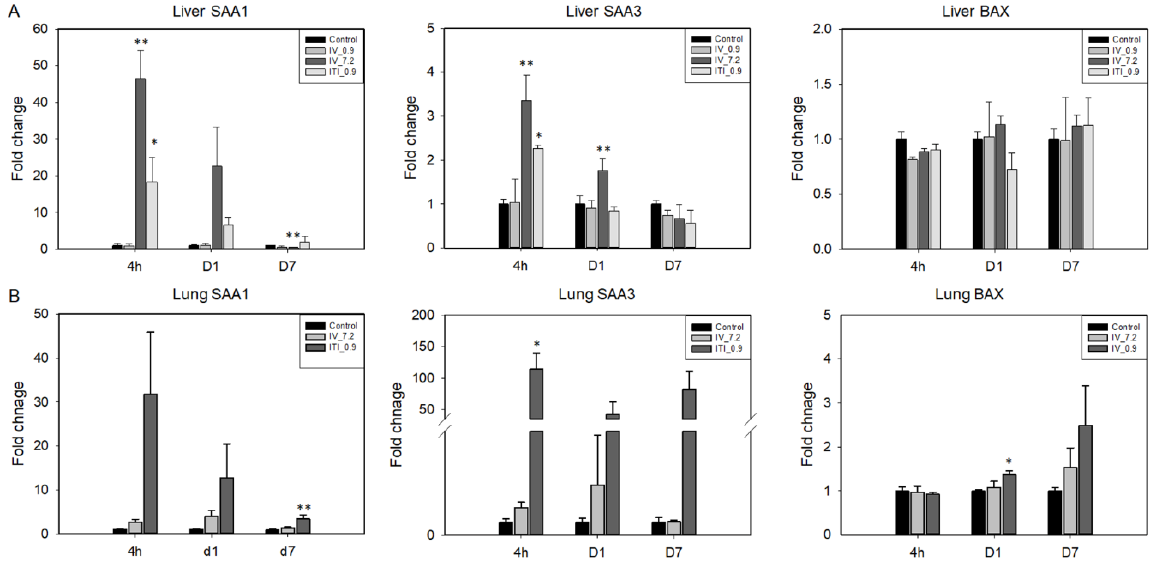
Figure 6. Expression of injury- and apoptosis-related genes was analyzed in the liver and lung tissues using quantitative RT-PCR. mRNA levels of SAA1, SAA3, and BAX in the liver ( A ) and lungs ( B ) are shown. Bars represent the mean ± standard deviation ( n = 3–4). Values are significantly different from the control group: * p < 0.05, ** p < 0.01.